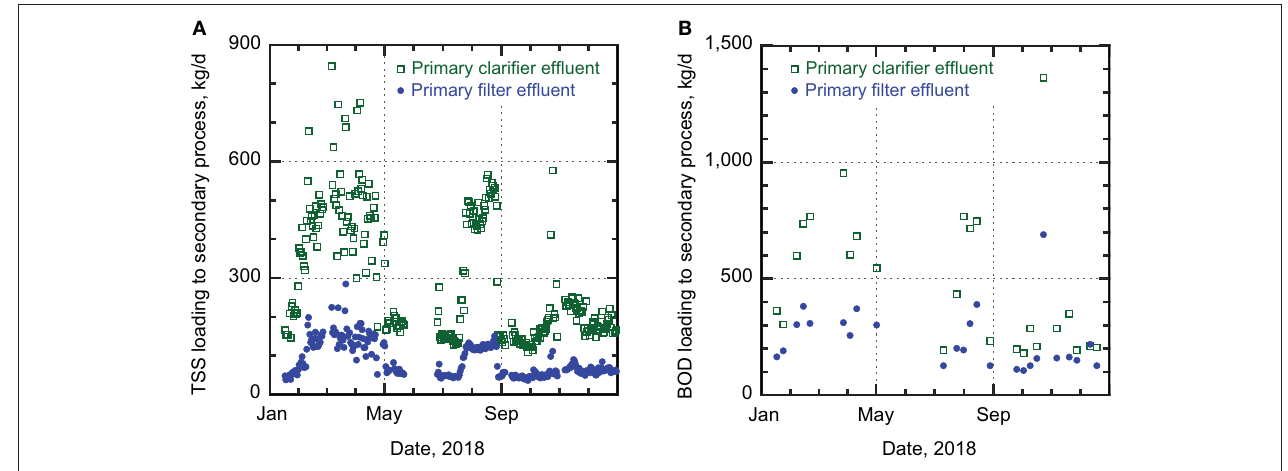
FIGURE 4 | Average daily mass loadings from a primary clarifier compared to primary filtration (A) TSS and (B) BOD [Adapted from Caliskaner et al. (2019)].